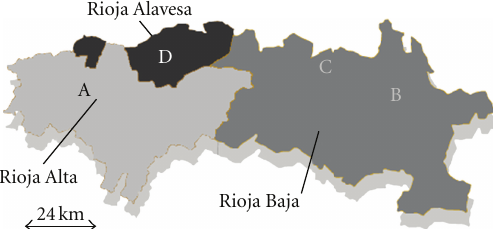
Figure 1: Location of the four wineries in the three subzones of the Appellation of Origin